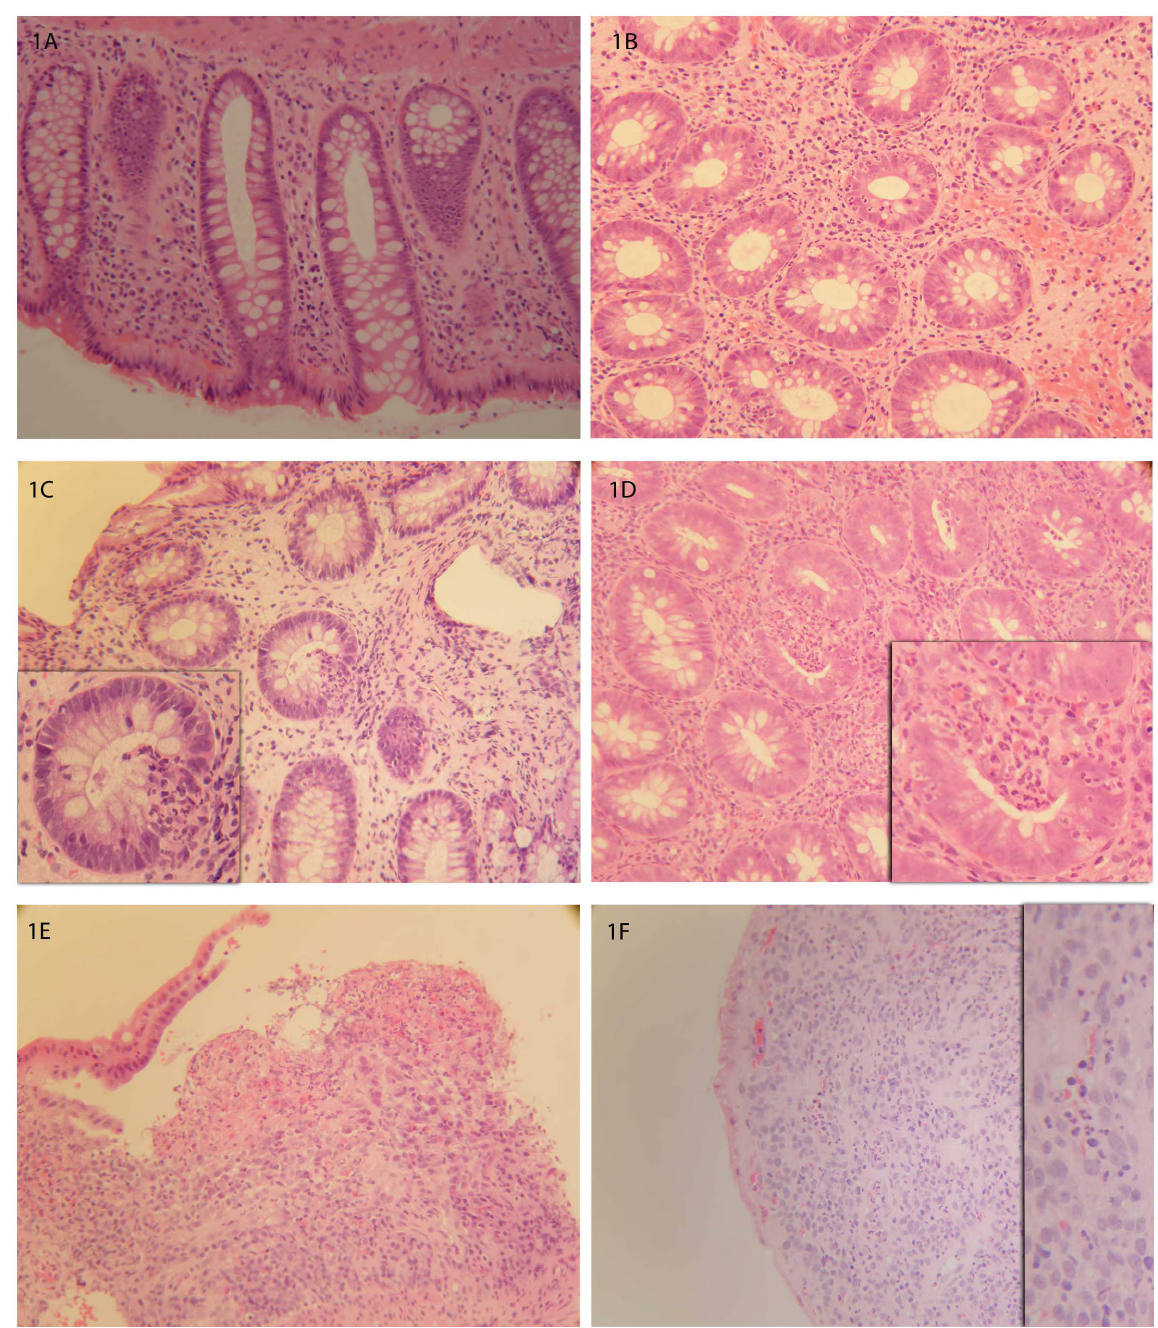
Figure 1. Gomes histological classification of UC. 1A: Gomes 0 (normal); 1B: Gomes 1 (mild oedema and inflammation in lamina propria with cryptitis); 1C: Gomes 2 (crypt abscess formation and inflammation); 1D: Gomes 3 (destructive crypt abscesses + / 2 granulomata); 1E–F: Gomes 4 (active ulceration and formation of granulation tissue with neoangiogenesis).